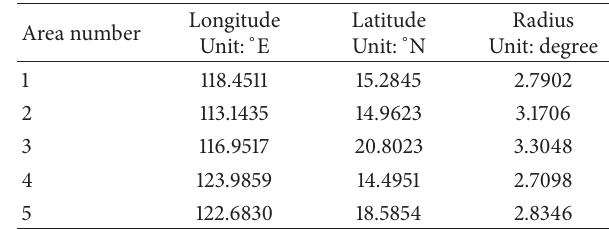
Table 1: The geometric centers and scopes of five areas.